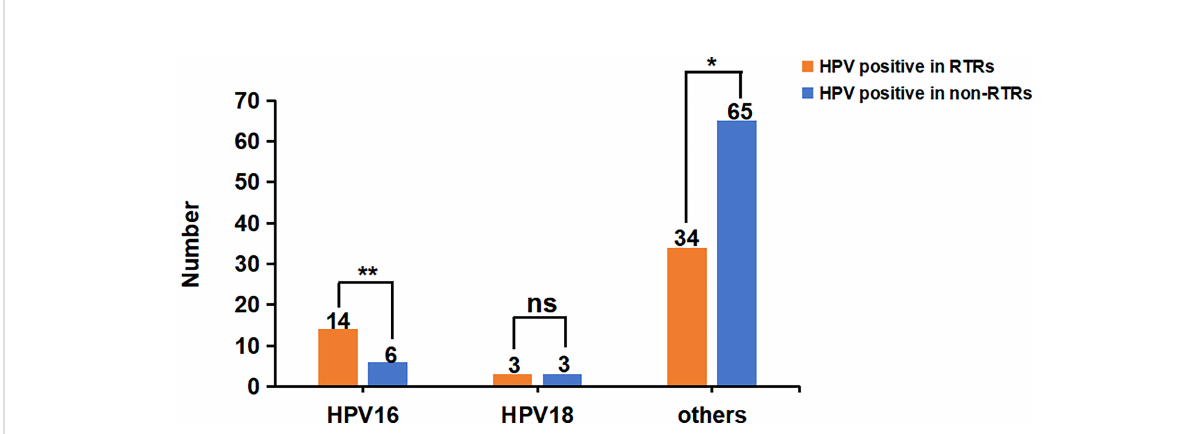
FIGURE 3 Comparison of different types of hrHPV infection in RTRs and non-RTRs. There were 46 RTRs and 72 non-RTRs with hrHPV infection, respectively. The prevalence of HPV16 in RTRs was much higher (30.4% vs. 8.3%, P=0.002), but the infection rate of HPV18 was not signi fi cantly different between the two groups (6.5% vs. 4.2%, P=0.890). The prevalence of hrHPV infection other than 16,18 in RTRs was lower than that in non-RTRs (73.9%vs. 90.3%, P=0.018). *P < 0.05; **P < 0.01; ns, no signi fi